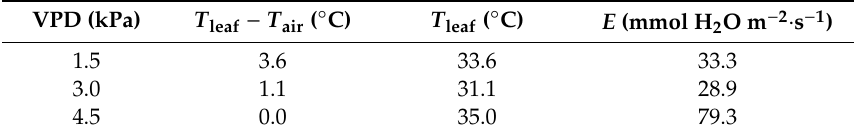
Table 2. Leaf overheating ( T leaf − T air , ◦ C), leaf temperature ( T leaf , ◦ C), and leaf transpiration ( E , mmol H 2 O m − 2 s − 1 ) when stomatal conductance is g s,max for Q. coccifera under di ff erent levels of vapor pressure deficit (VPD, kPa) according to the climatic conditions considered (see Figure 7 for details). T leaf − T air ( ◦